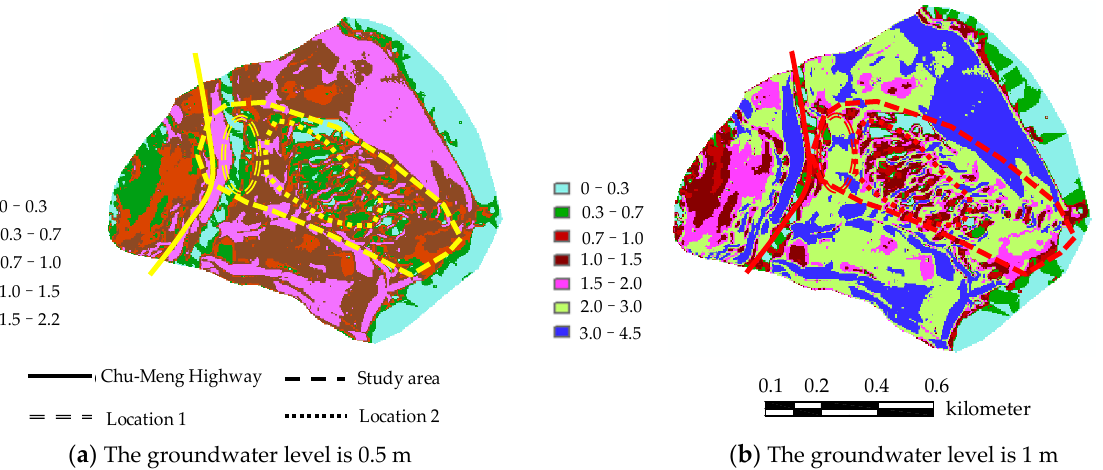
Figure 12. Schematic diagram of variation of groundwater level in each slope unit.